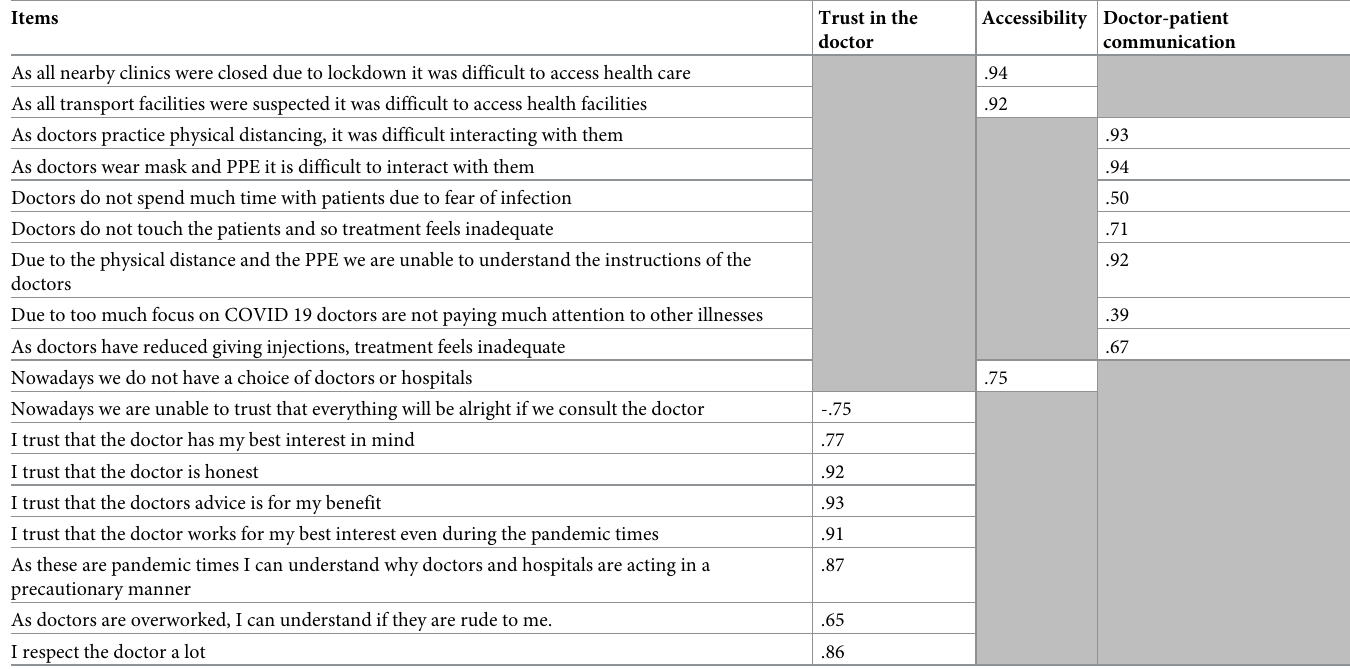
Table 3. Exploratory factor analysis showing the grouping of variables into three dimensions and their factor weights. Items